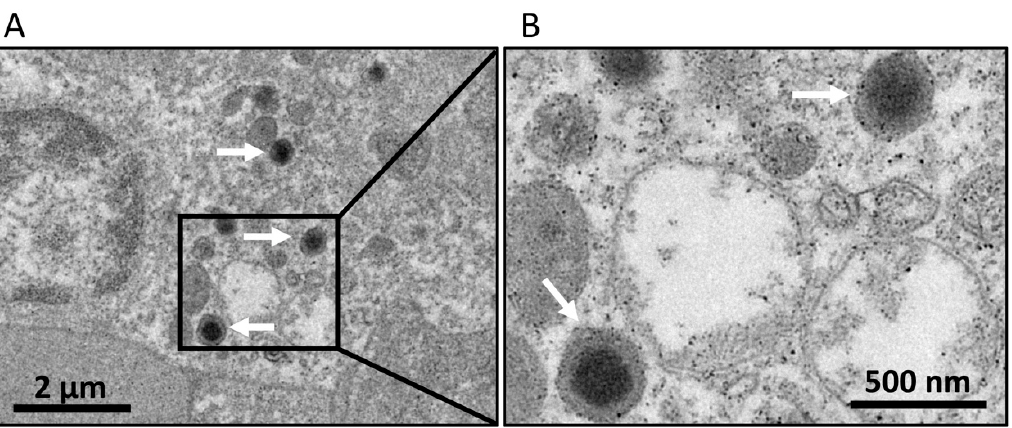
Figure 1. Electron micrograph of viral particles in the cells of spleen tissues. ( A ) Numerous viral particles are in the same cell. ( B ) The outer membranes and central electron-lucent core of mature virions are visible in the enlarged image. Black square area of ( A ) is enlarged in the ( B ). White arrow indicating the virus particle.